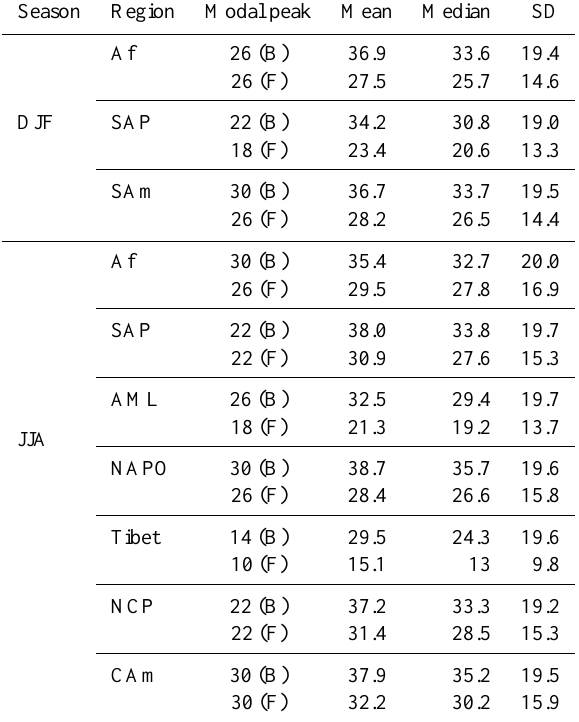
Table 2. Characteristic numbers of the distribution of transit times for the contributing regions during boreal winter (DJF) and boreal summer (JJA). All the quantities are in units of days. The modal peak is based on the discretized mean histogram shown in Fig. 4. The mean, median and standard deviation are calculated from a cu- bic spline interpolation over the 0–90-dayinterval. For each region and each season the upper line refers to backward calculations and the lower line to forward calculations as indicated in the modal peak column. Regions with low contribution have been